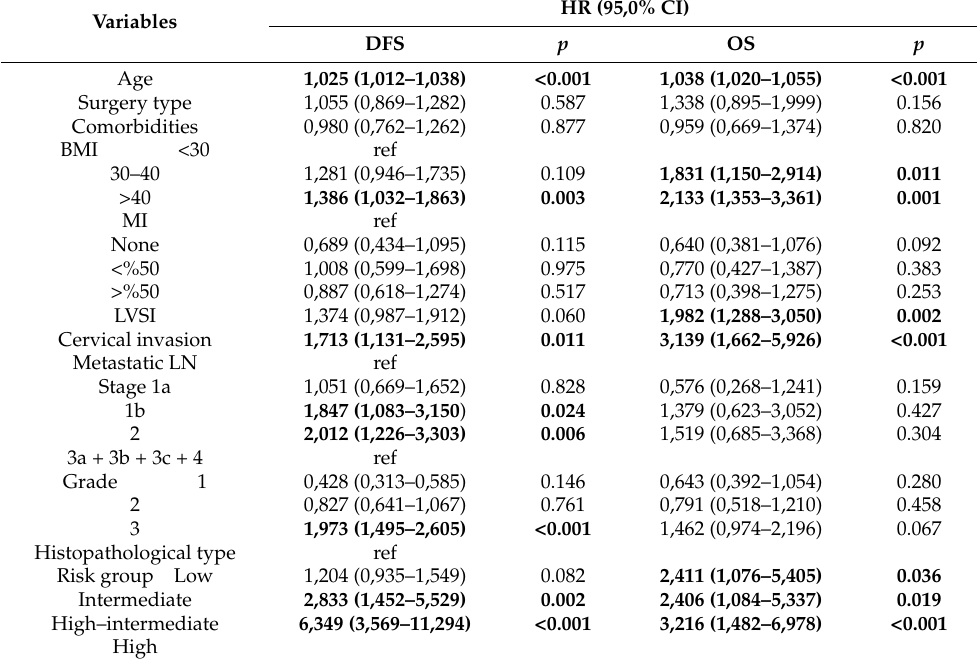
Table 5. Multivariate analysis of DFS and